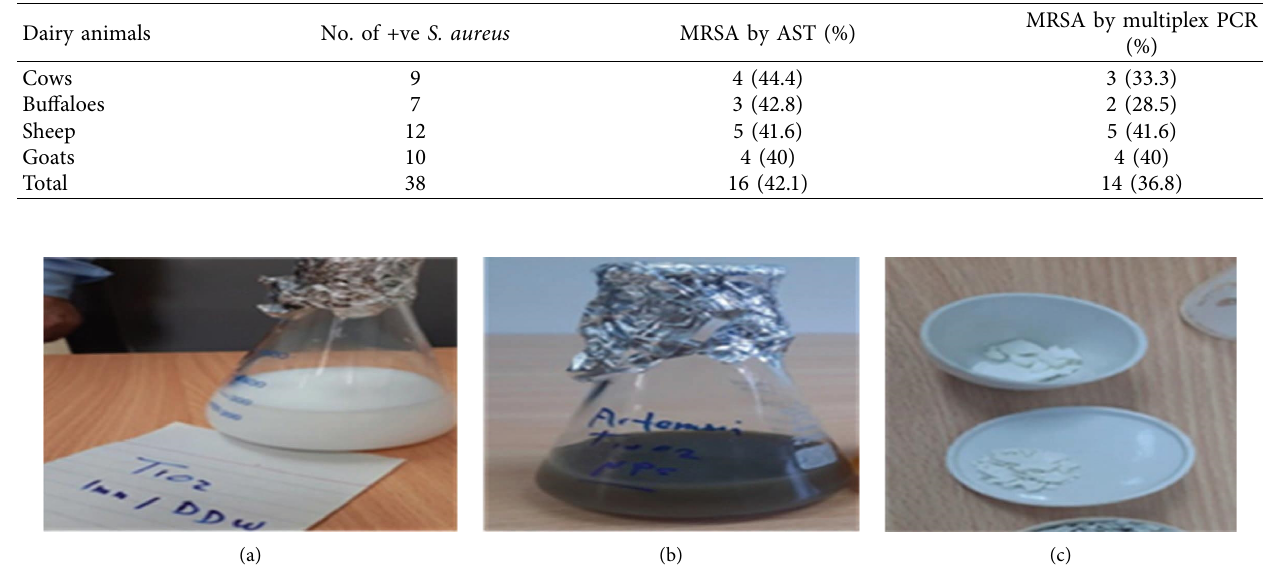
Figure 1: Formation of TiO2 NPs using A. herb Alba aqueous extract. (a) TiO2 solution. (b) A. herb Alba TiO2 NP powder. (c) TiO2 NP powder.